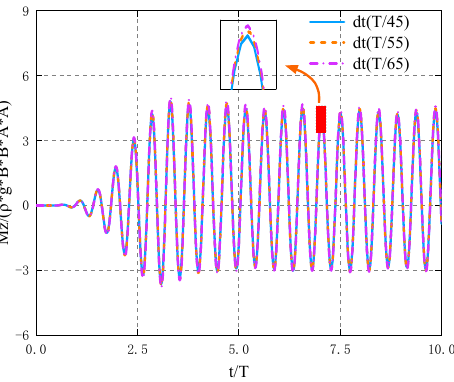
(37) Figure 10. Grid diagram of the longitudinal section of the computing domain.